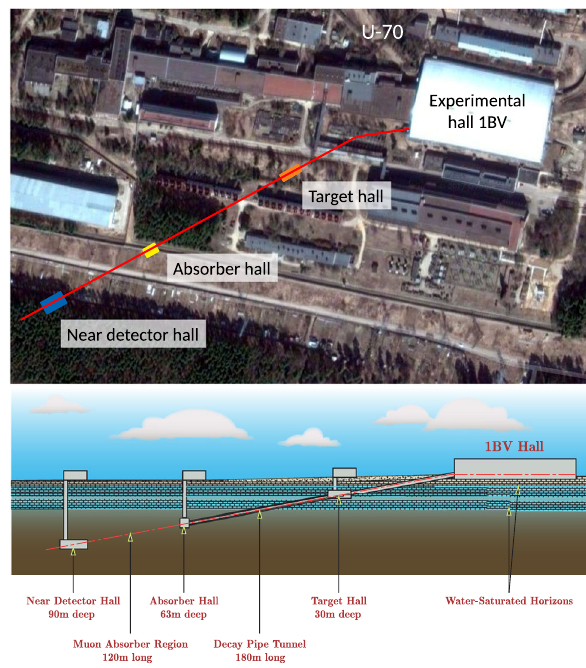
Fig. 4 Top view and elevation view of the proposed neutrino beamline (the baseline